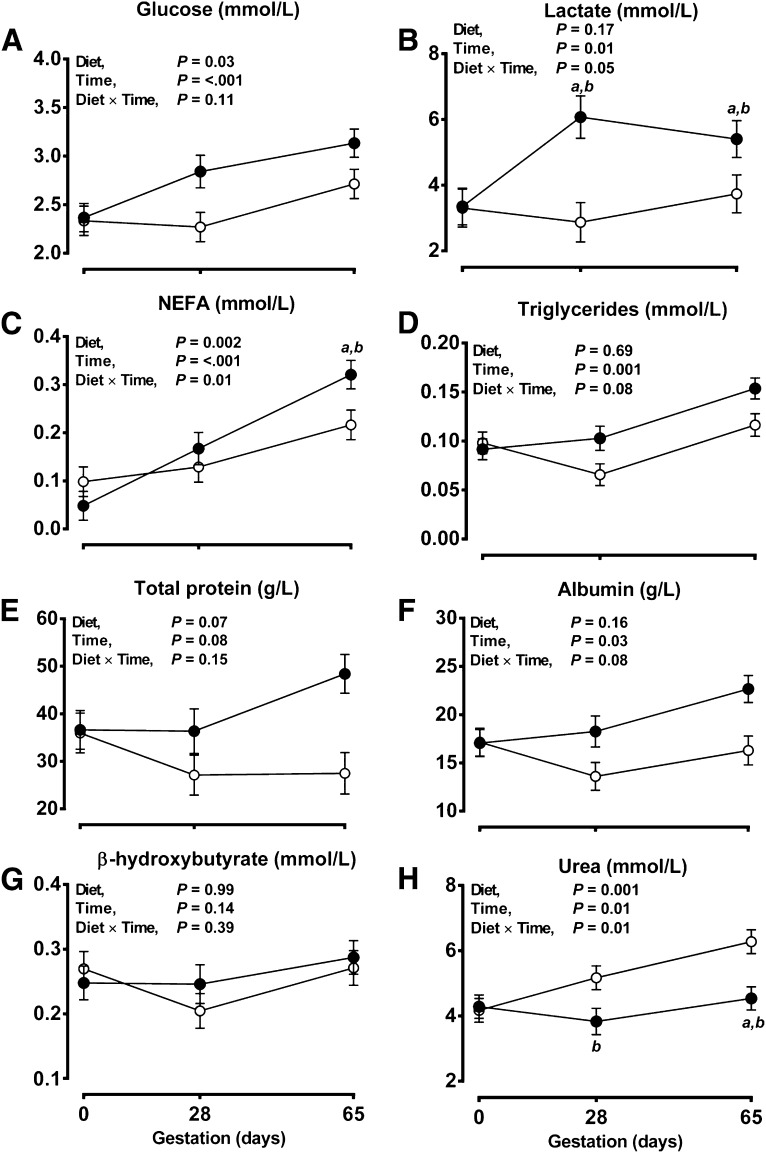
Ewes fed LP diet have reduced plasma urea, but other biomarkers of nutritional status are increased. Glucose (A), lactate (A), NEFA (C), triglyceride (D), total protein (E), albumin (F), β-hydroxybutyrate (G), and urea (H) samples were obtained prior to pregnancy (d 0′) and at d 28 and 65 of gestation and were analyzed on a Randox Rx-Imola bioanalyzer. Data are means ± estimated sem for ewes fed a CP diet (n=15; open symbols) or an LP diet (n=16; solid symbols) during early gestation (d 0–65, term ∼145 d). Data were analyzed by the general linear model for the fixed effect of diet, with time included as a repeated measure, and the interaction term (diet×time) using Genstat 15. NS, nonsignificant; NEFA, nonesterified fatty acid. aP < 0.05 vs. d 0. bP < 0.05 vs. control group.